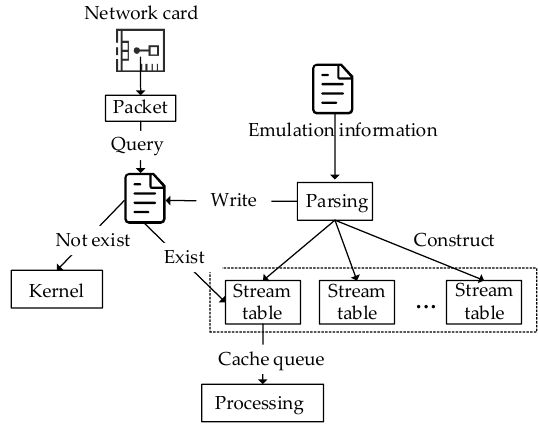
Figure 3. Packet-receiving process.